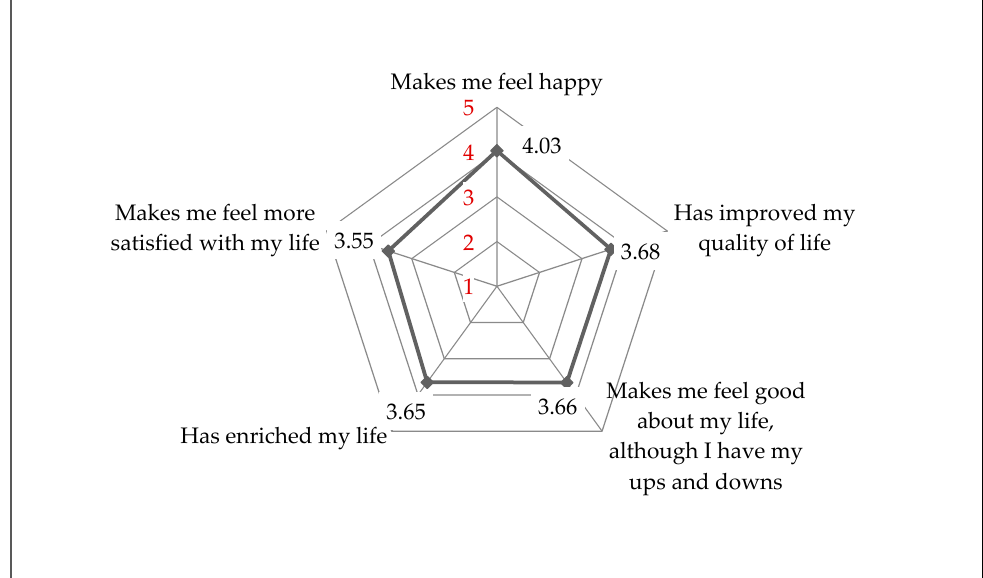
Figure 6. Assessment of the variable Quality of